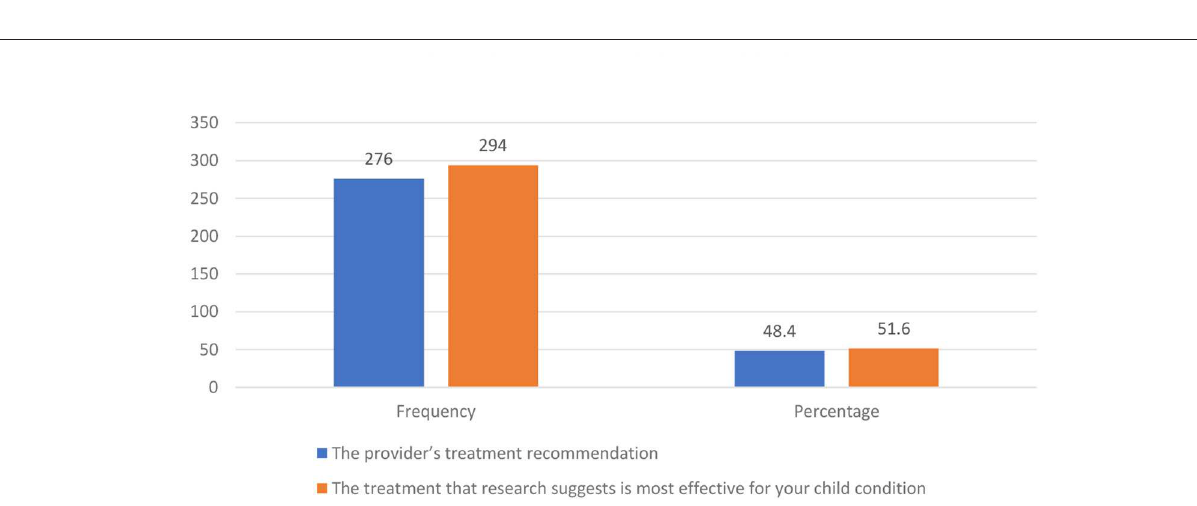
FIGURE 2 | Likelihood to recommend cognitive behavioral therapy (CBT) to a friend with a child having emotional difficulties.